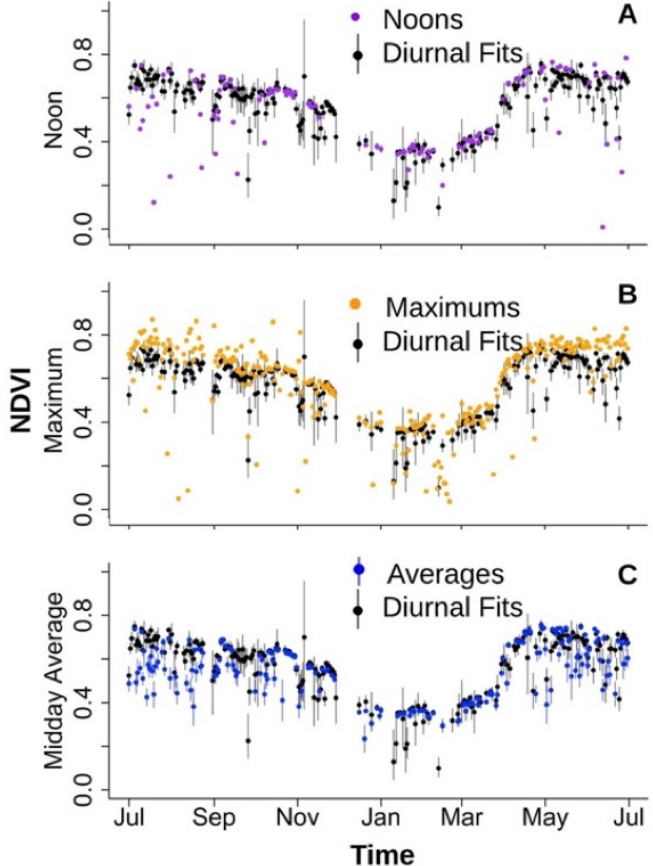
Figure 5. Plot showing that methods can produce vastly di ff erent NDVI values based on how susceptible they are to noise. The expected maximum / midday NDVI values are shown in solid lines. The blue background shading indicates the 95% CI on the window average. The 95% CI on the diurnal fit estimate (red shading) is barely visible. Two potential noon measurements (11:57 and 12:02) are given to show the sensitivity to noise this method has. The diurnal fit method is less sensitive to noise and biases than the other potential methods of maximum, noon value, and midday window average.